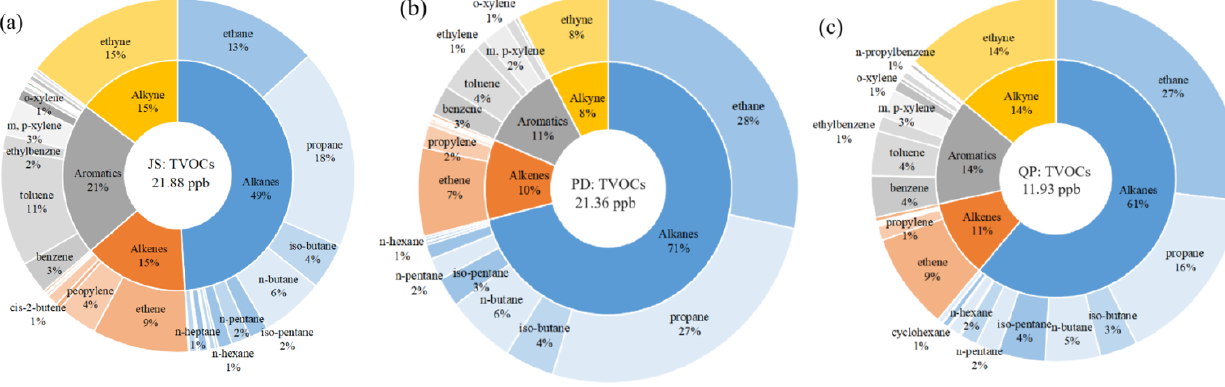
Figure 2. Contributions of the VOC categories (43 species) at the (a) JS, (b) PD and (c) QP sites (the contributions > 1% were